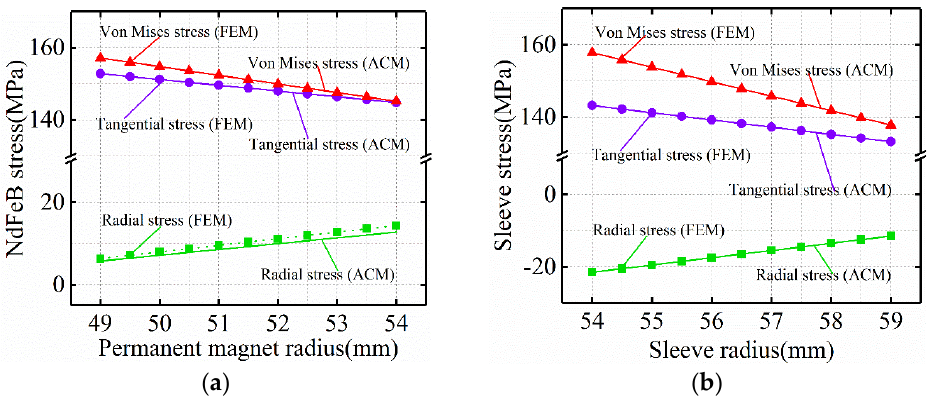
Figure 14. Stress distribution of ( a ) NdFeB-PM and ( b ) sleeve under hot rotating condition.